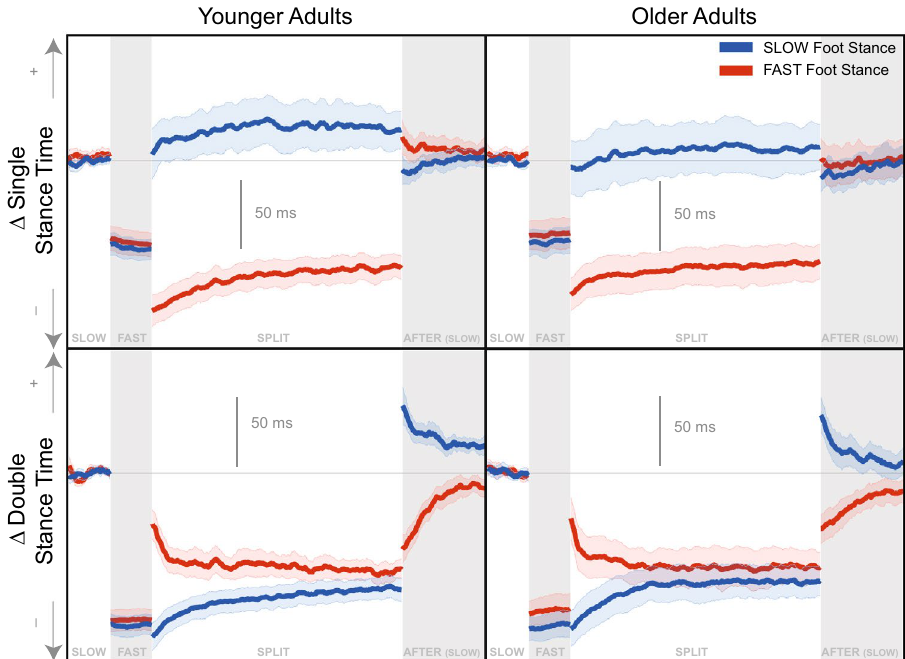
Figure 2. Temporal Gait Parameters adaptation time series graphs for younger (left column) and older (right column) adults. The time-series data were smoothed with a 2 step sliding window moving average for display purposes. The blue data corresponds to the right foot, and the foot that made contact with the slow belt during split condition. The red data corresponds to the left foot, and the foot that made contact with the fast belt during split condition. The bolded lines indicate the group mean. The shaded areas represent the 95% confidence interval of the group mean. All values are represented as a change from the average of the slow condition ( (cid:31) ). + indicates more time for both